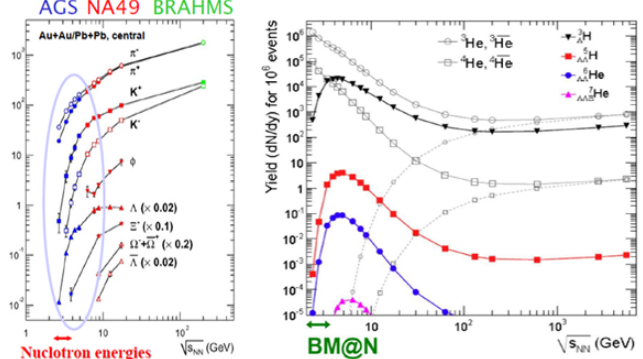
Figure 1. Left plot: Yields of mesons and (anti-) hyperons measured in di ff erent experiments as a func- tion of the energy per nucleon- nucleon collision in c.m.s. for Au + Au and Pb + Pb collisions [5]. The √ S NN = 2.3 - 3.5 GeV. Right plot: Yields of hypernuclei Nuclotron beam energy range corresponds to predicted by the thermal model [3] for Au + Au collisions as a function of the nucleon-nucleon collision energy in c.m.s. Predictions for the yields of 3 He and 4 He nuclei are presented for comparison. The Nuclotron BM@N energy range is